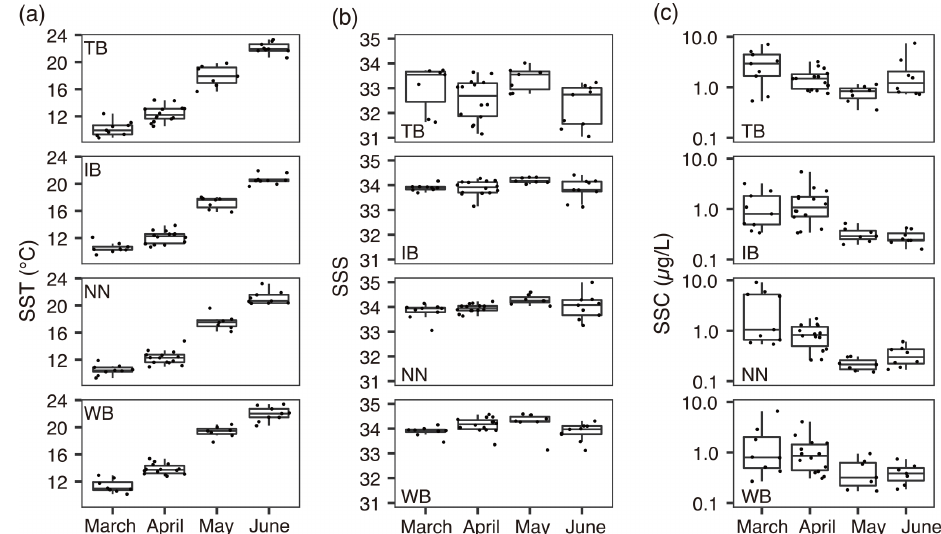
Figure 2. Variations of environmental parameters among months and stations. (a) Sea surface temperature (SST), (b) sea surface salinity (SSS), and (c) sea surface chlorophyll a concentration (SSC). Values at TB, IB, NN, and WB are shown. Box plots show the medians (horizontal lines within boxes), upper and lower quartiles (boxes), and quartile deviations (bars). Small points are raw data points. In (a) , the lowest outlier at TB in March (SSS = 28) is not